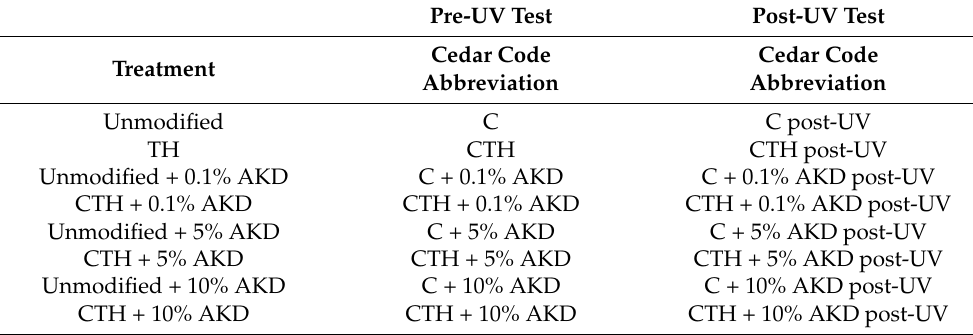
Table 1. Experimental design of unmodified and thermally modified cedar wood samples for the different solutions of alkyl ketene dimer (AKD) (% w / w ). CTH = thermally modified. C = unmodified . Pre-UV Test Post-UV Test Cedar Code Cedar Code Treatment Abbreviation Abbreviation Unmodified C C post-UV CTH